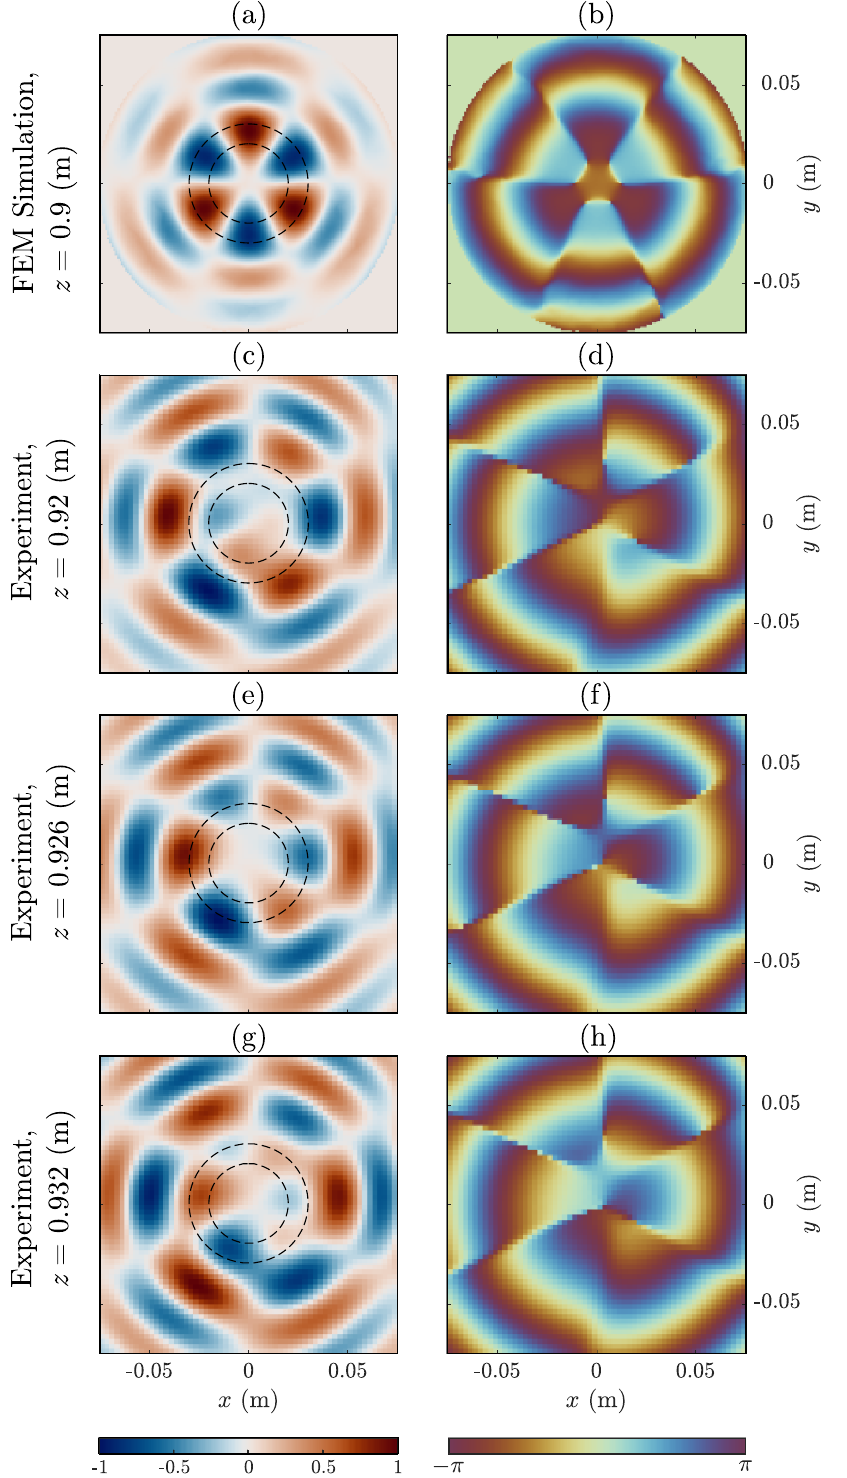
Fig. 6 Results at 53 kHz at different depths. Frequency domain real pressure fi eld (left column) and phase (right column), at 53 kHz. a , b FEM Simulation with x − y measurement plane at z = 0.9 m (according to the coordinate system adopted in Figs. 3b & 7) i.e., at the submerged end of the pipe. c , d Experimental results at the acoustic centre of the microphone, z = 0.92 m as in Fig. 2. e , f , g , h are subsequent measurements at x − y planes 6 mm deeper: z = 0.926 m and z = 0.932 m, respectively. The dashed black circles show the inner and outer radii of the pipe, highlighting the divergence of the acoustic beam as it propagates deeper in the fl